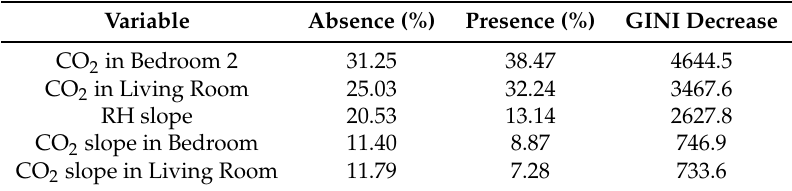
Table 3. Relevance of variables for the presence model. Gini coefficient is related to Mean Decrease in Impurity.